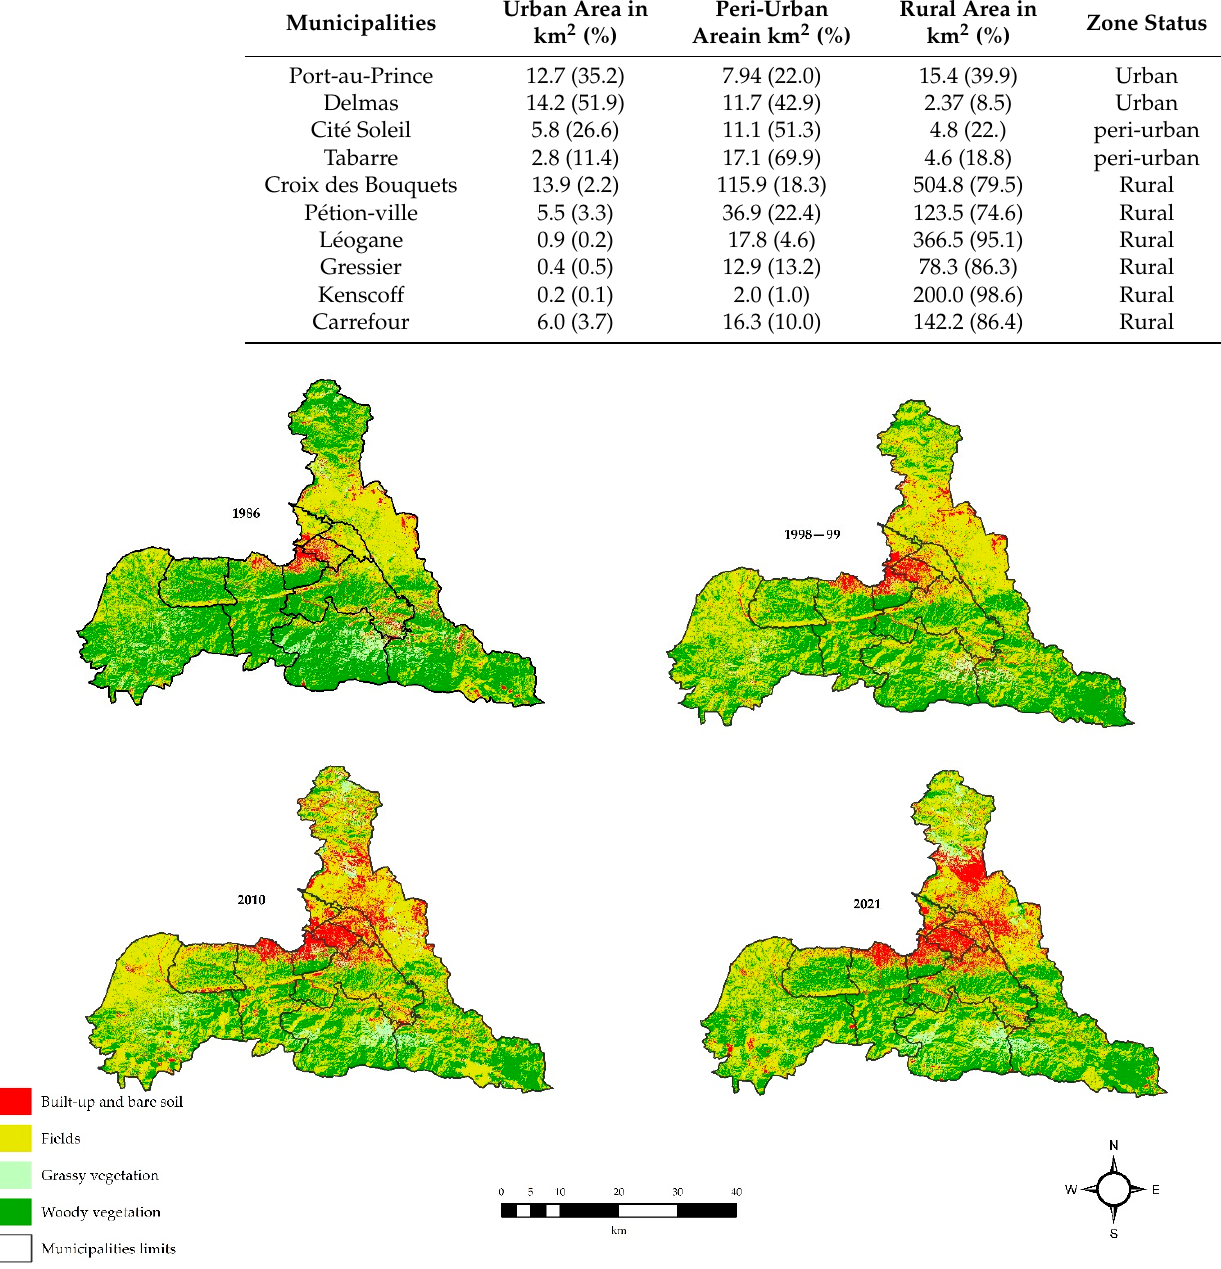
Table 5. Morphological status of the municipalities along the urban–rural gradient of the Port-au- Prince agglomeration according to [43] typology. These results are derived from the supervised classification of the Landsat image mosaics of 2021 based on the maximum likelihood algorithm.